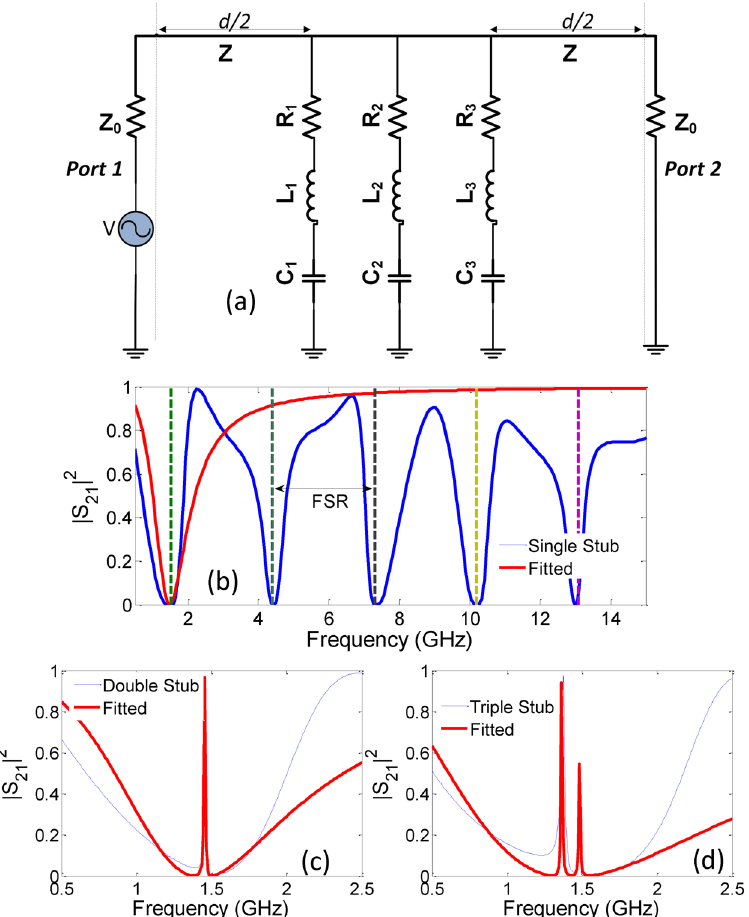
Figure 6. ( a ) Equivalent circuit model for EIT resonator consisting of three connected RLC loops to the main transmission line of length d. Fitted curves for ( b ) single (the resonances repeat periodically at frequency interval given by FSR), ( c ) double, ( d ) triple open-circuited stub resonators.